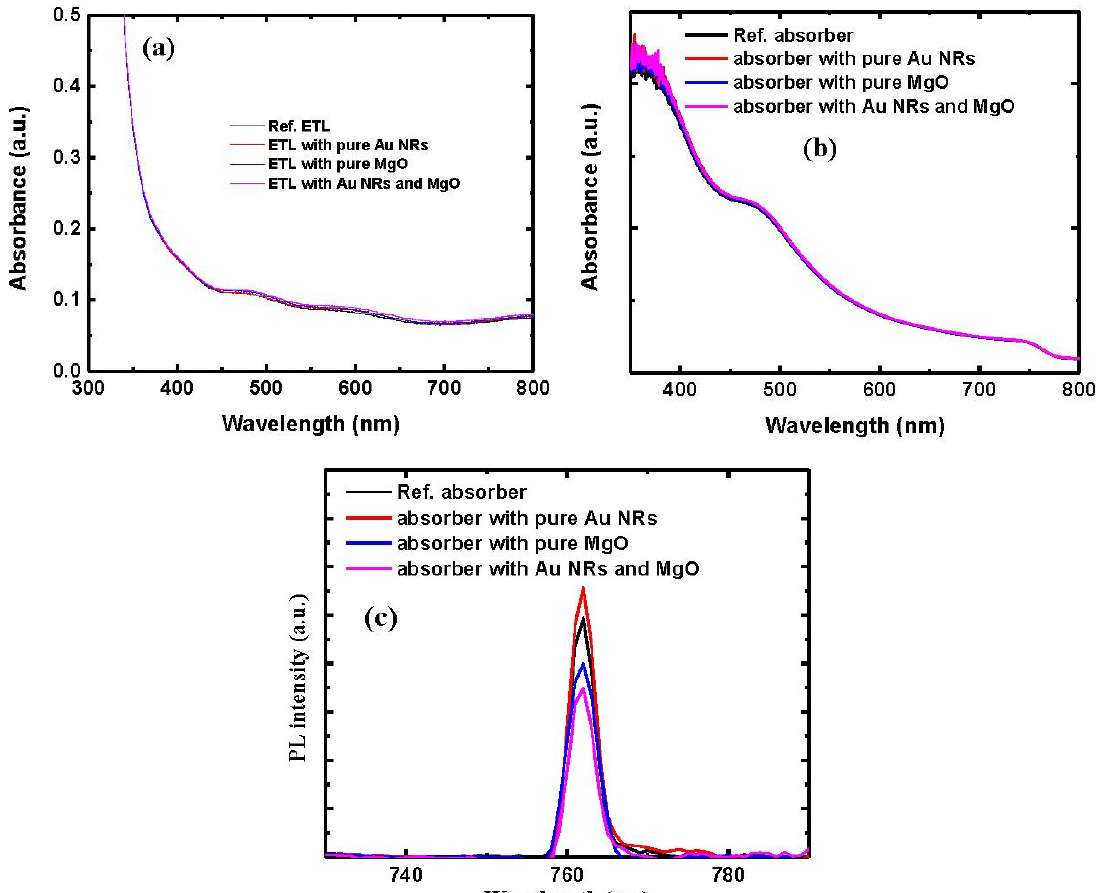
Figure 2. UV–vis absorption of ( a ) p-TiO 2 electron transport layers (ETLs) and ( b ) perovskite absorbers formed on porous TiO 2 without and with Au NRs and MgO coating. ( c ) Steady-state photoluminescence (PL) spectra of perovskite absorbers without and with Au NRs and MgO coating.